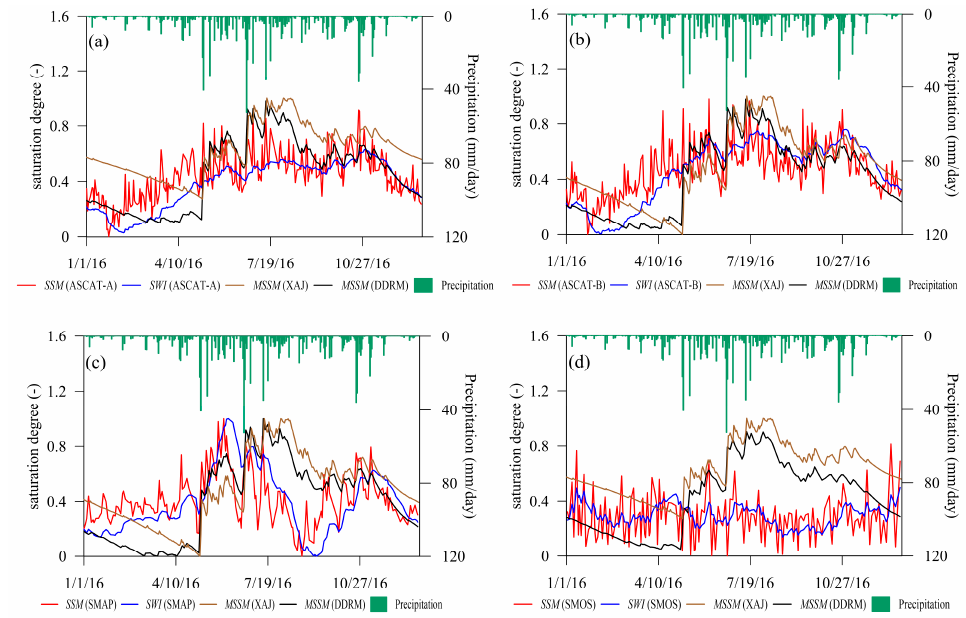
Figure 11 shows the catchment-averaged (cid:2033) (cid:3020)(cid:3020)(cid:3014)(cid:3019)(cid:3020) and (cid:2033) (cid:3020)(cid:3024)(cid:3010)(cid:3019)(cid:3020) time series and their corresponding catchment-averaged ω XAJ and ω DDRM during 2016. For each satellite, the range of (cid:2033) (cid:3020)(cid:3020)(cid:3014)(cid:3019)(cid:3020) is wider than that of (cid:2033) (cid:3020)(cid:3024)(cid:3010)(cid:3019)(cid:3020) , and (cid:2033) (cid:3020)(cid:3024)(cid:3010)(cid:3019)(cid:3020) fits better with the model-simulated soil moisture than (cid:2033) (cid:3020)(cid:3020)(cid:3014)(cid:3019)(cid:3020) . It can be seen from Figure 11c that SMAP product is drying faster than the model-simulated soil moisture after rainfall events, and all satellite products respond faster than the model-simulated soil moisture with rainfall events. It is mainly because satellites observe the surface soil moisture, which usually responds quickly to weather conditions, while there is a time delay in soil moisture simulations from models.